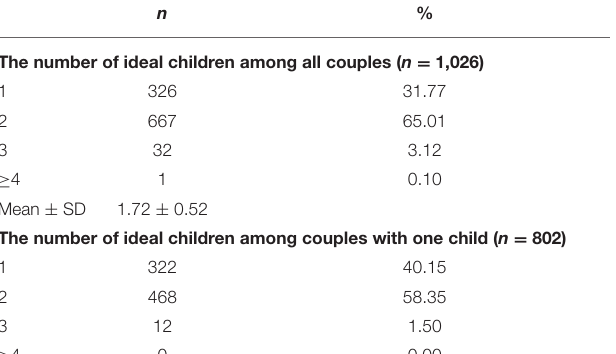
TABLE 2 | The overall intention for the number of children among study participants. n % The number of ideal children among all couples ( n =